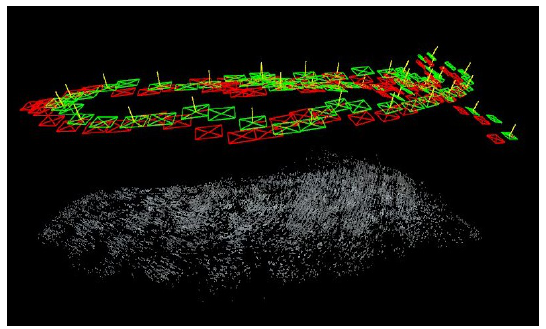
Figure 8. RealTime SLAM process